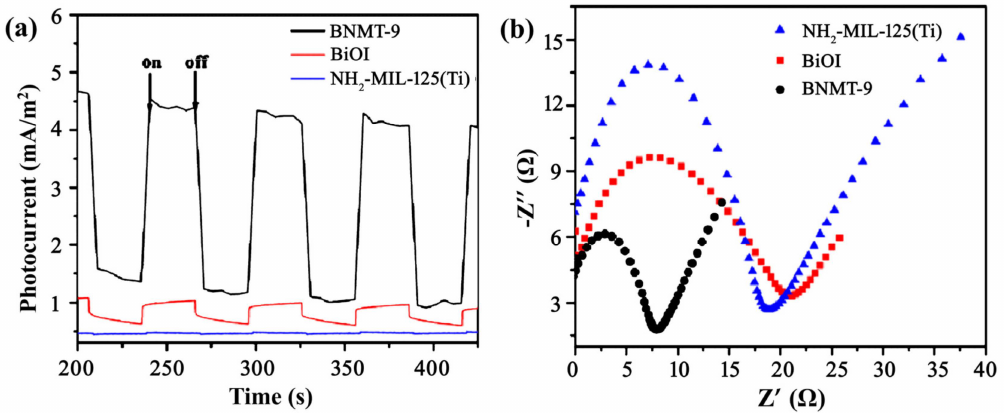
Figure 6. ( a ) Photocurrent responses of BNMT-9, BiOI, and NH 2 -MIL-125(Ti), and ( b ) Impedance diagrams of BNMT-9, BiOI, and NH 2 -MIL-125(Ti).